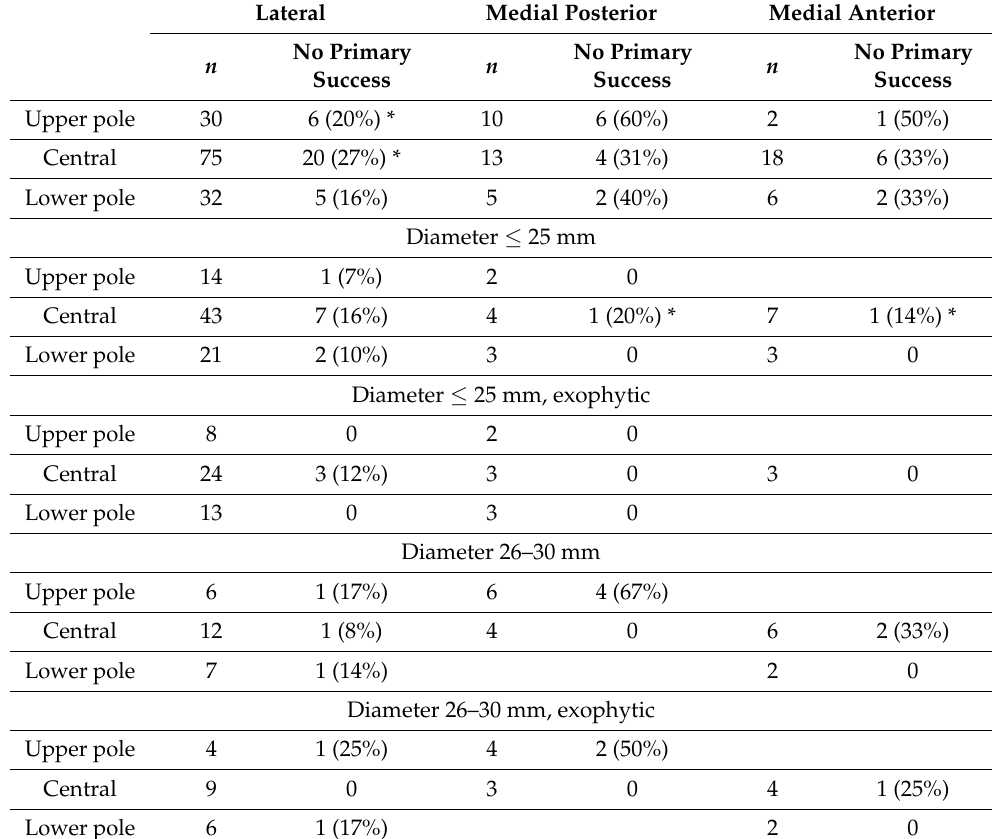
Table 2. Primary ablation success according to tumour size and location.